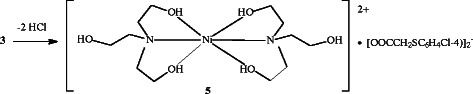
Conversion of compound 3 into compound 5.